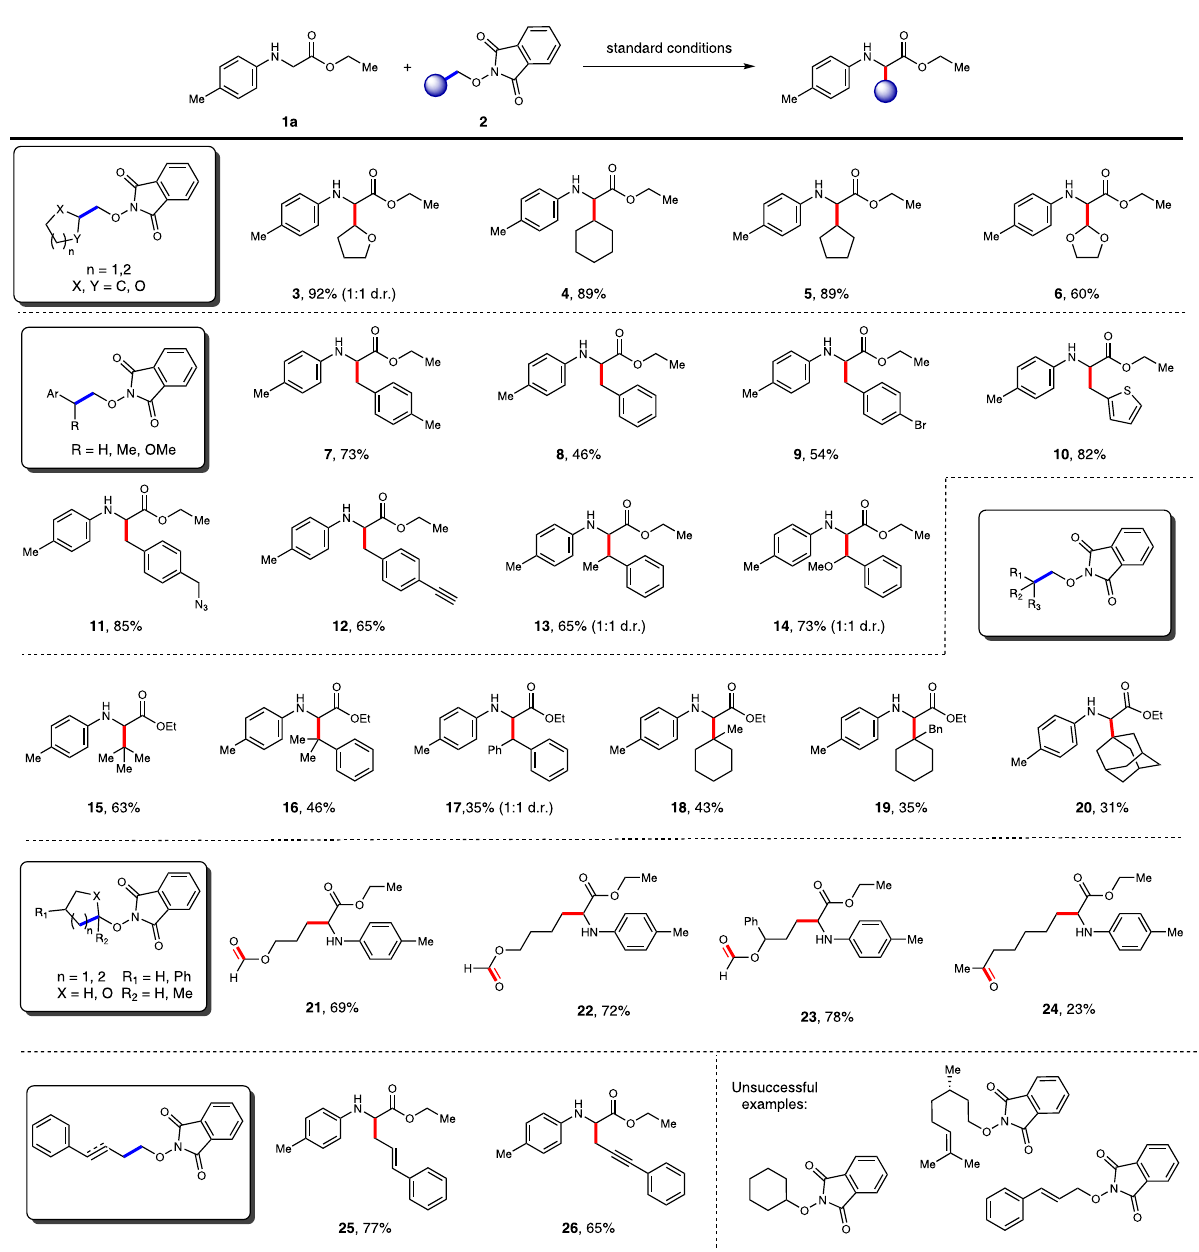
Fig. 2 | Scope of N -alkoxyphthalimides (broken bonds highlighted in blue and formed bonds highlighted in red). Conditions: All reactions were carried out with 4CzIPN (5mol%), 1a ( 0.2mmol), 2 (0.1mmol), and DMSO (0.03M) irradiated under 15W Blue LEDs at